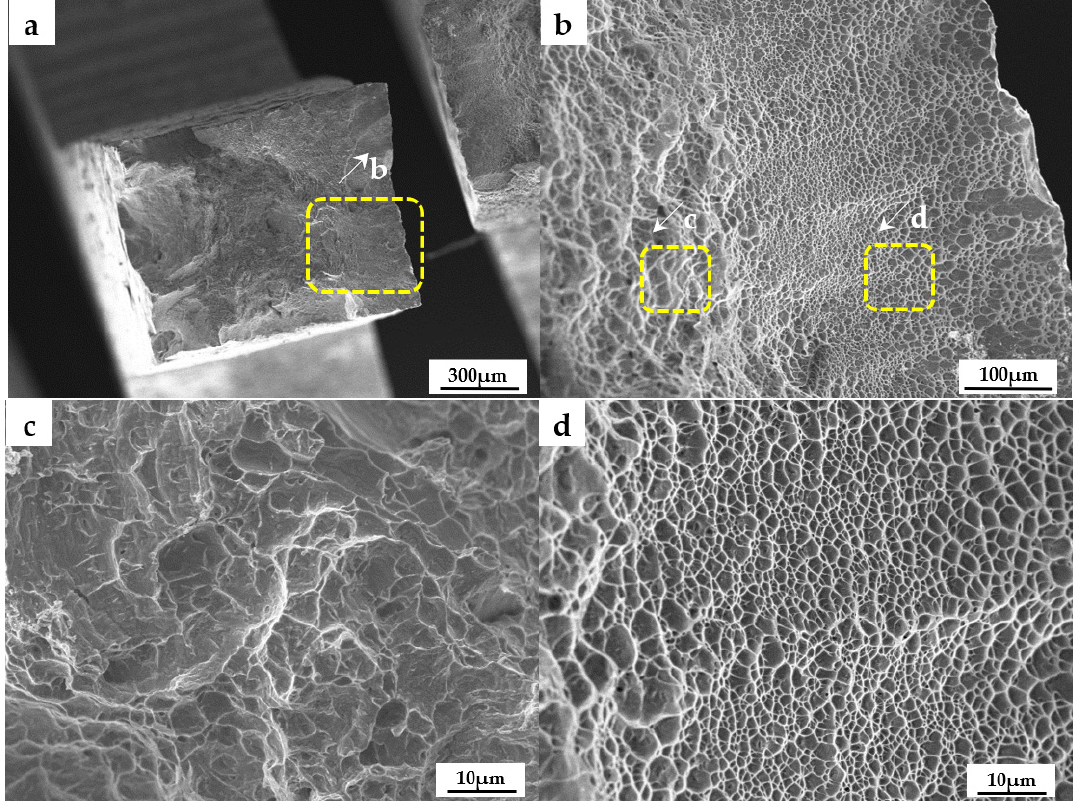
Figure 6. Fracture morphology under different magnification: ( a ) Overall fracture surface morphology; ( b ) Enlargement in the corresponding yellow box of ( a ); ( c ) Enlargement in the corresponding yellow box of ( b ); ( d ) Enlargement in the corresponding yellow box of ( b ).